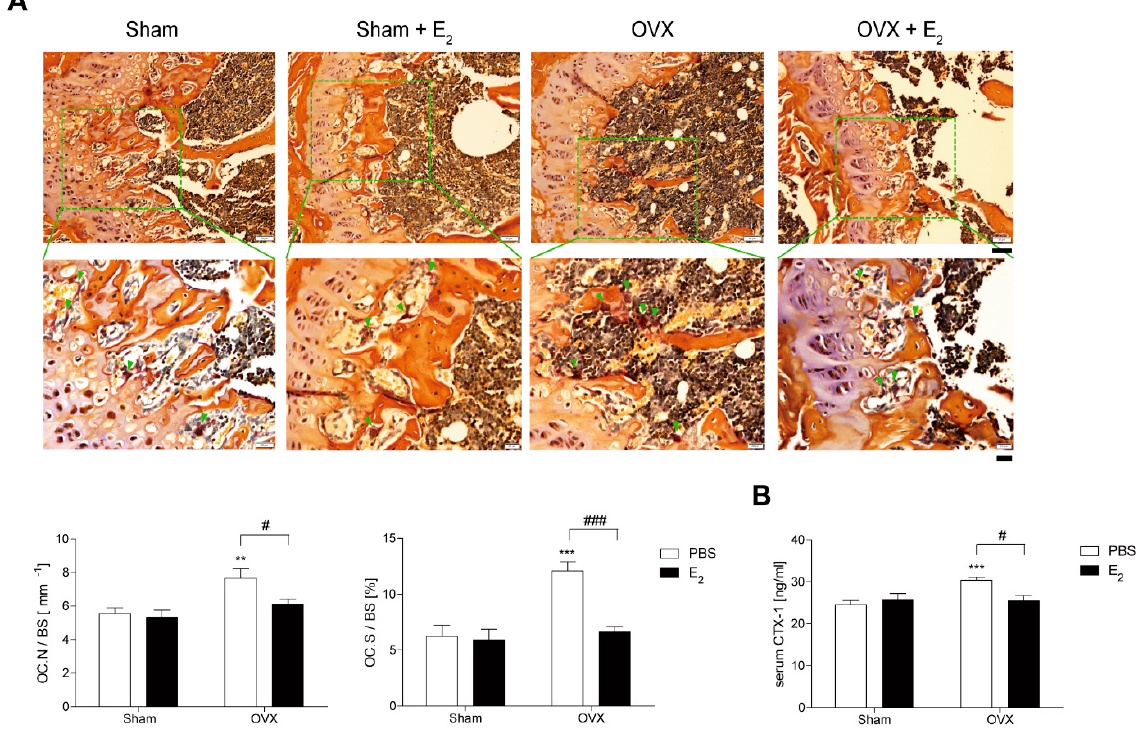
Figure 1. E 2 decreases number and size of osteoclasts (OCs) during bone loss in ovariectomy (OVX) mice. ( A ) Representative histological sections of the distal femoral metaphysis of mice from each of the 4 groups were stained for tartrate-resistant acid phosphatase (TRAP) to identify OCs (indicated by arrows) to calculate OC surface area divided by total bone surface area (OC.S/BS) and OC number divided by total bone surface (OC.N/BS). Scale bar in the representative photos: 50 µ m. Inset shows higher magnification (scale bar: 20 µ m). ( B ) Serum carboxy-terminal collagen crosslinks-1 (CTX-1) in vivo bone resorption marker. ** p < 0.01; *** p < 0.001 compared with sham mice. # p < 0.05; ### p < 0.001 compared with PBS-injected mice. Two-way ANOVA, followed by Bonferroni posttests was used to compare the effect of E 2 (OC.N/BS and serum CTX-1; p < 0.05, OC.S/BS; p < 0.001), the effect of surgery (serum CTX-1; p < 0.05, OC.N/BS; p < 0.01, OC.S/BS; p < 0.001 ) and interactions (OC.S/BS; p < 0.01, serum CTX-1; p < 0.05) ( A - B ).